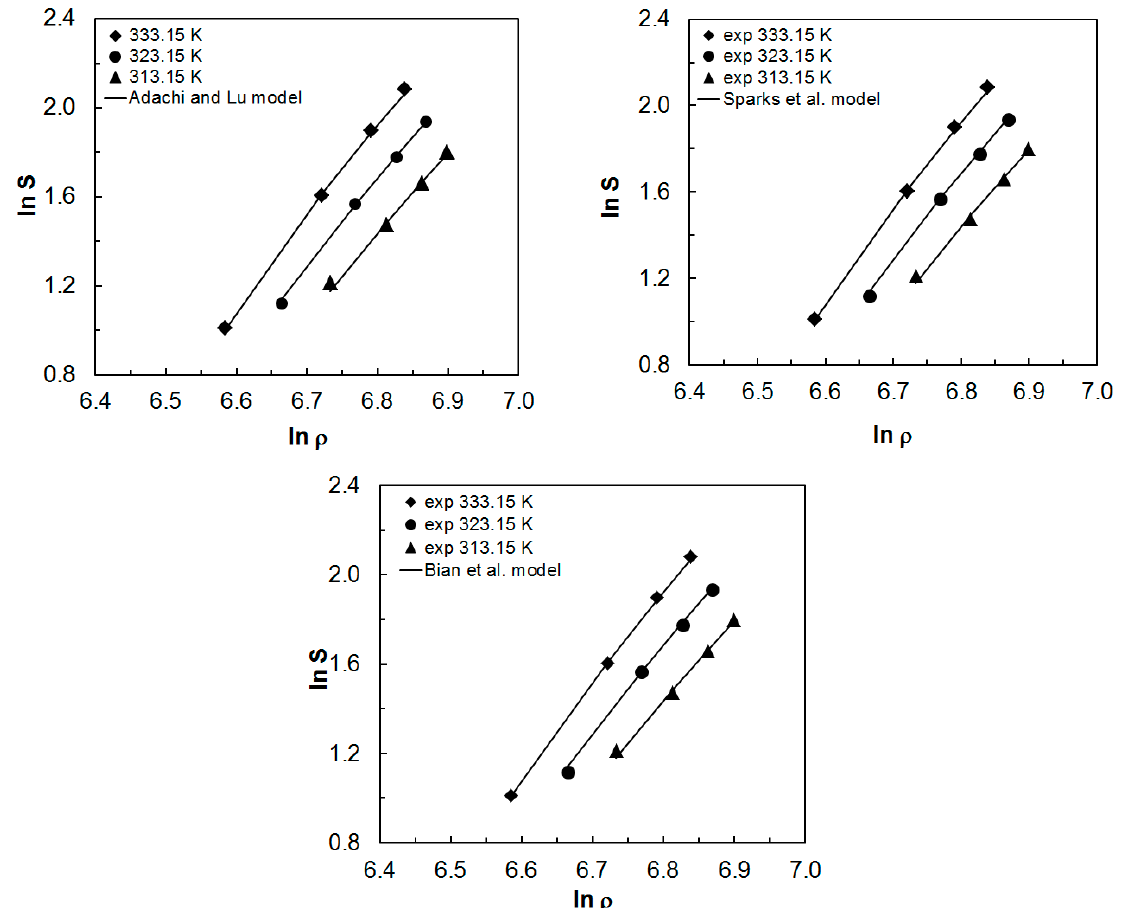
Figure 3. Comparison of the experimental and correlated solubility data.